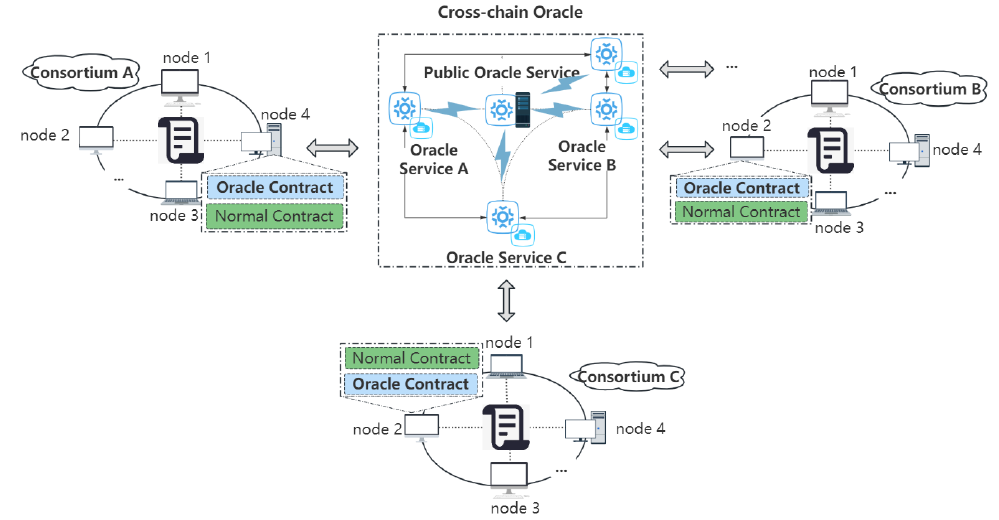
Figure 1. The overall architecture of